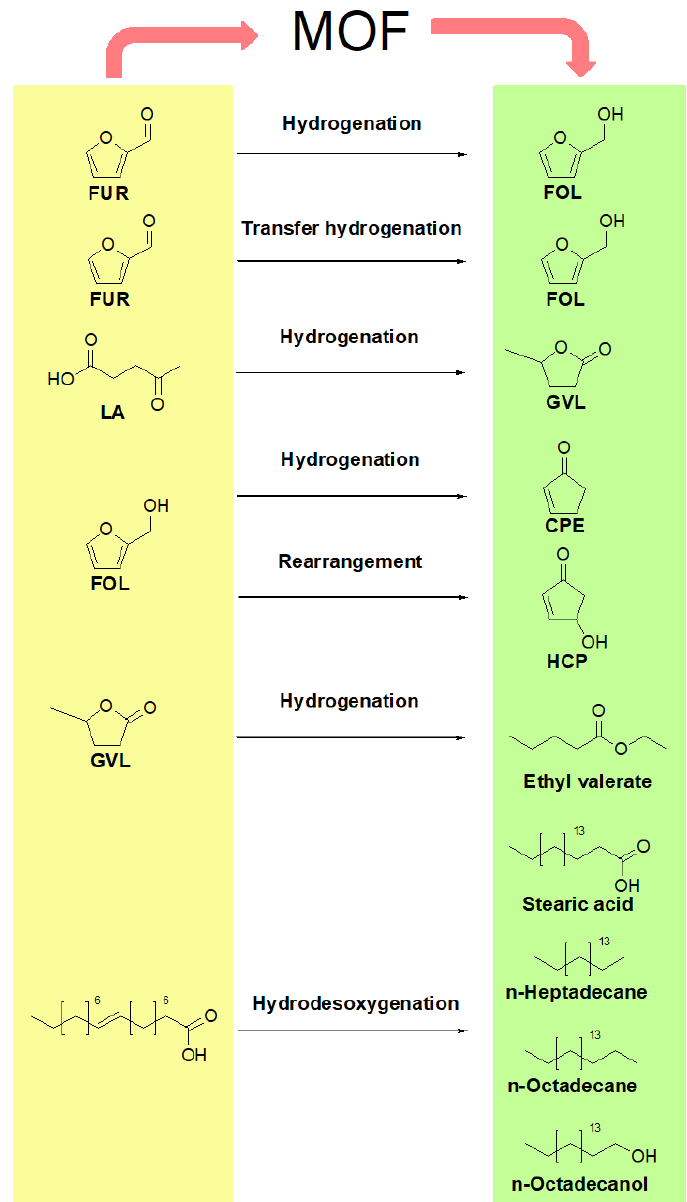
Figure 4. Main products starting from different biomass precursors. Table 3. Different catalysts and catalytic conditions in hydrogenation reactions for biomass valori- sation.